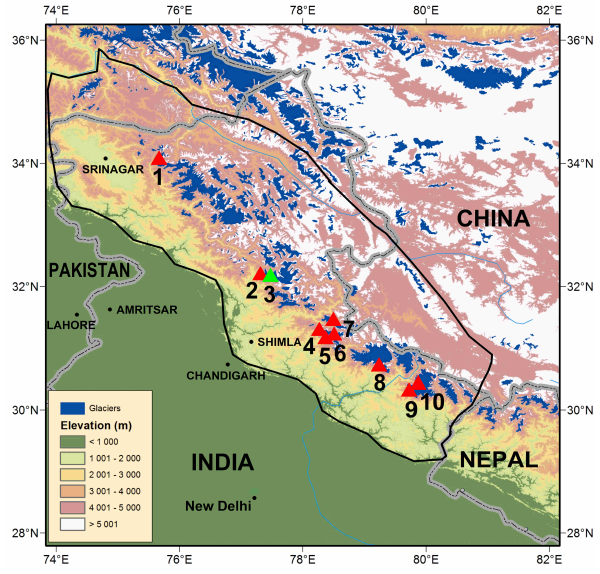
Fig. 1. Map of the western Himalayan glaciers with MB series longer than 1yr. Details on each glacier (triangles) can be found in Table 1 with the corresponding numbers. Chhota Shigri Glacier has number 3 (green triangle). The boundary of western Himalaya as defined in Bolch et al. (2012) is also reported. Political boundaries are tentative